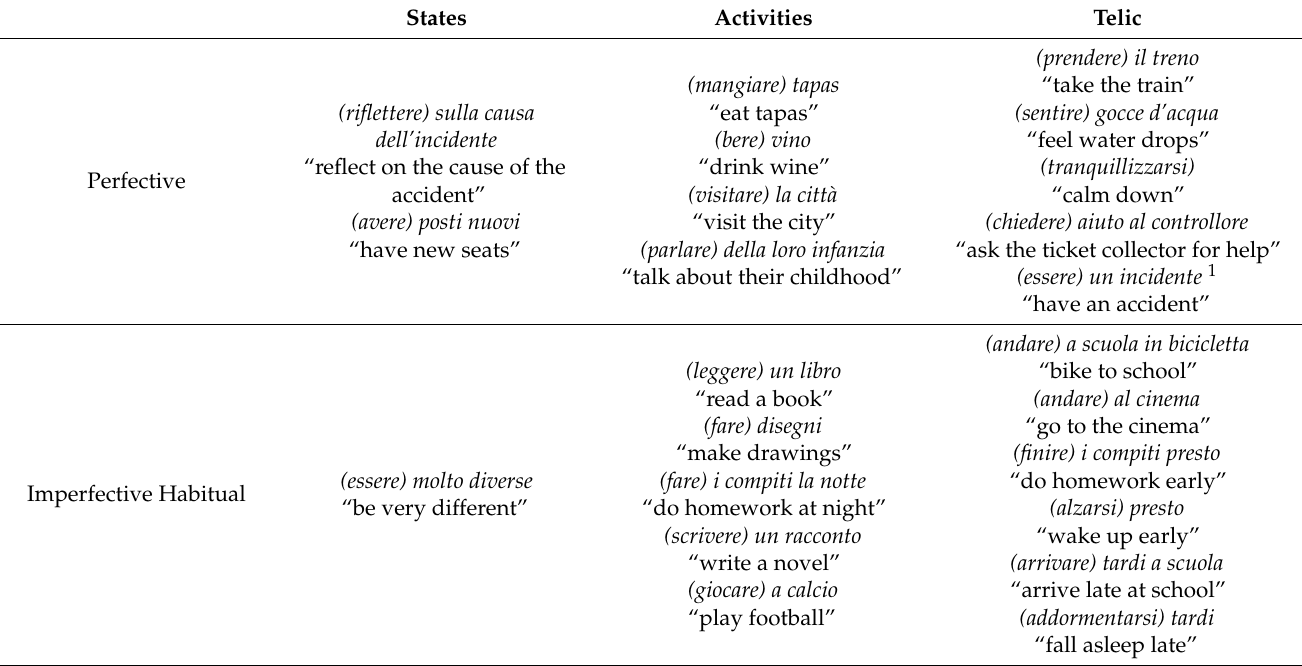
Table 2. Combinations of lexical aspect (states, activities, telic) and viewpoint aspect (perfective, imperfective habitual) in the oral retelling